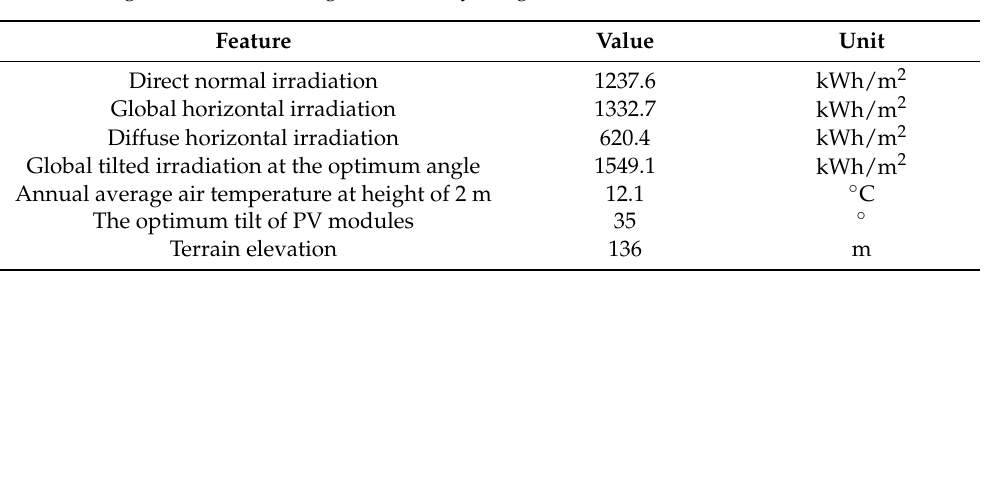
Table 1. Long-term annual average data for city Dragotin